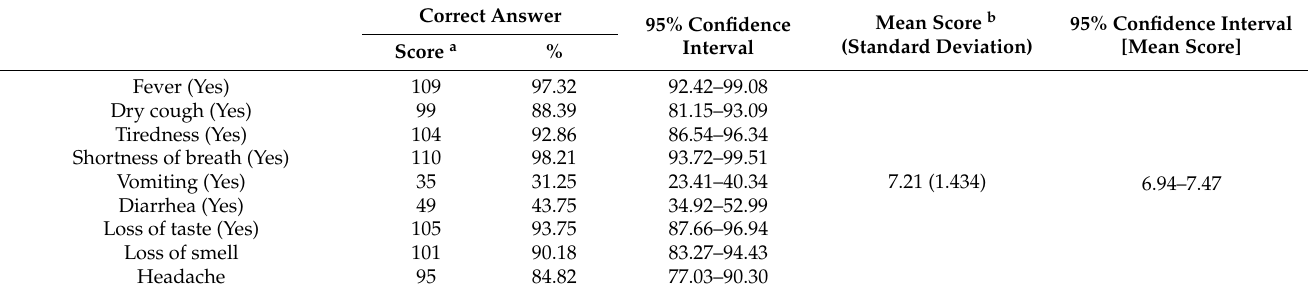
a Score: the total marks for the questions answered correctly. b Mean score: the mean calculated from the total marks of the